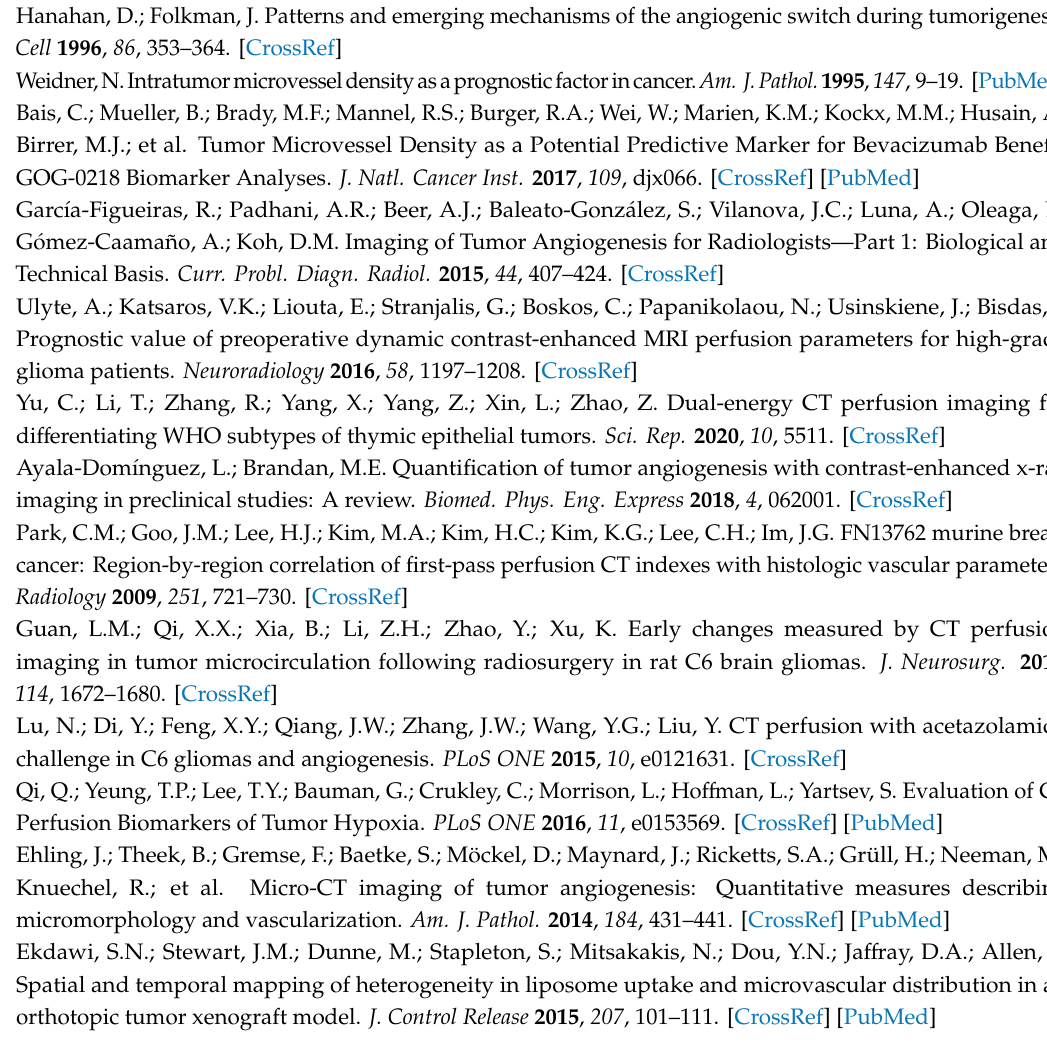
Figure S1: Representative histological samples of the subcutaneous C6 glioma model evaluated with the SE imaging protocol, Figure S2: Representative histological samples of the subcutaneous C6 glioma model evaluated with the DE imaging protocol, Figure S3: Representative histological samples of the subcutaneous C6 glioma model evaluated with the DCE imaging protocol, Table S1: Average VOI size and estimated number of pixels used for the quantification of imaging parameters for several tissues / organs in SE and DE micro-CT